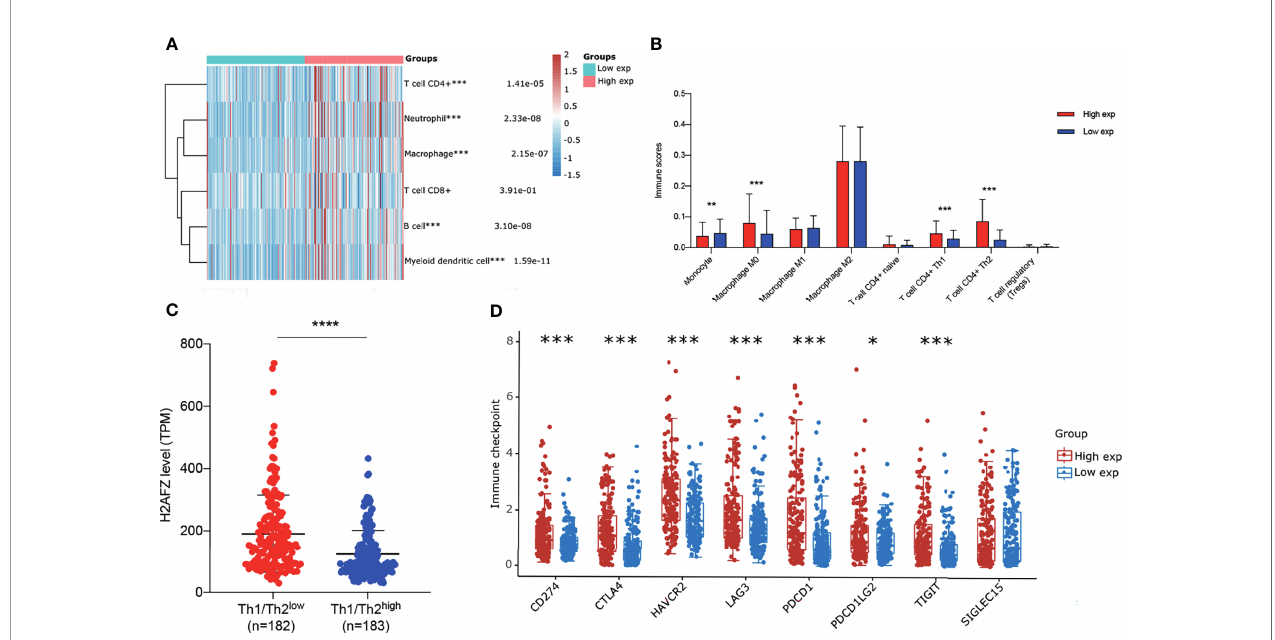
FIGURE 9 | Correlation of H2AFZ and immune in fi ltrations in HCC. (A) The score distribution of CD4+ T cells, neutrophils, macrophages, CD8+ T cells, B cells, and myeloid dendritic cells in the H2AFZ high group and H2AFZ low group, estimated by TIMER. (B) Scores of monocytes, macrophage M0, macrophage M1, macrophage M2, naive CD4+ T cells, Th1 cells, Th2 cells, and Tregs in the H2AFZ high group and the H2AFZ low group, estimated by CIBERSORT and xCell (Mann – Whitney tests, * p < 0.05, ** p < 0.001, *** p < 0.0001). (C) Differential H2AFZ expression level in Th1/Th2 high patients and Th1/Th2 low patients (Mann – Whitney test, p < 0.00001). (D) Expression levels of immune-checkpoint-relevant transcripts in the H2AFZ high and H2AFZ low group, respectively (Mann – Whitney tests, * p < 0.05, ** p < 0.001, *** p <